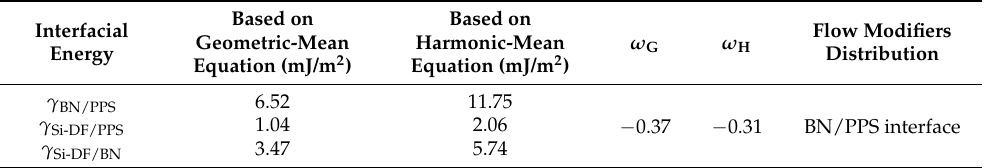
Table 3. Preferential distribution of Si-DF in the BN/PPS composites according to interfacial energies γ and wetting coefficients ω a .